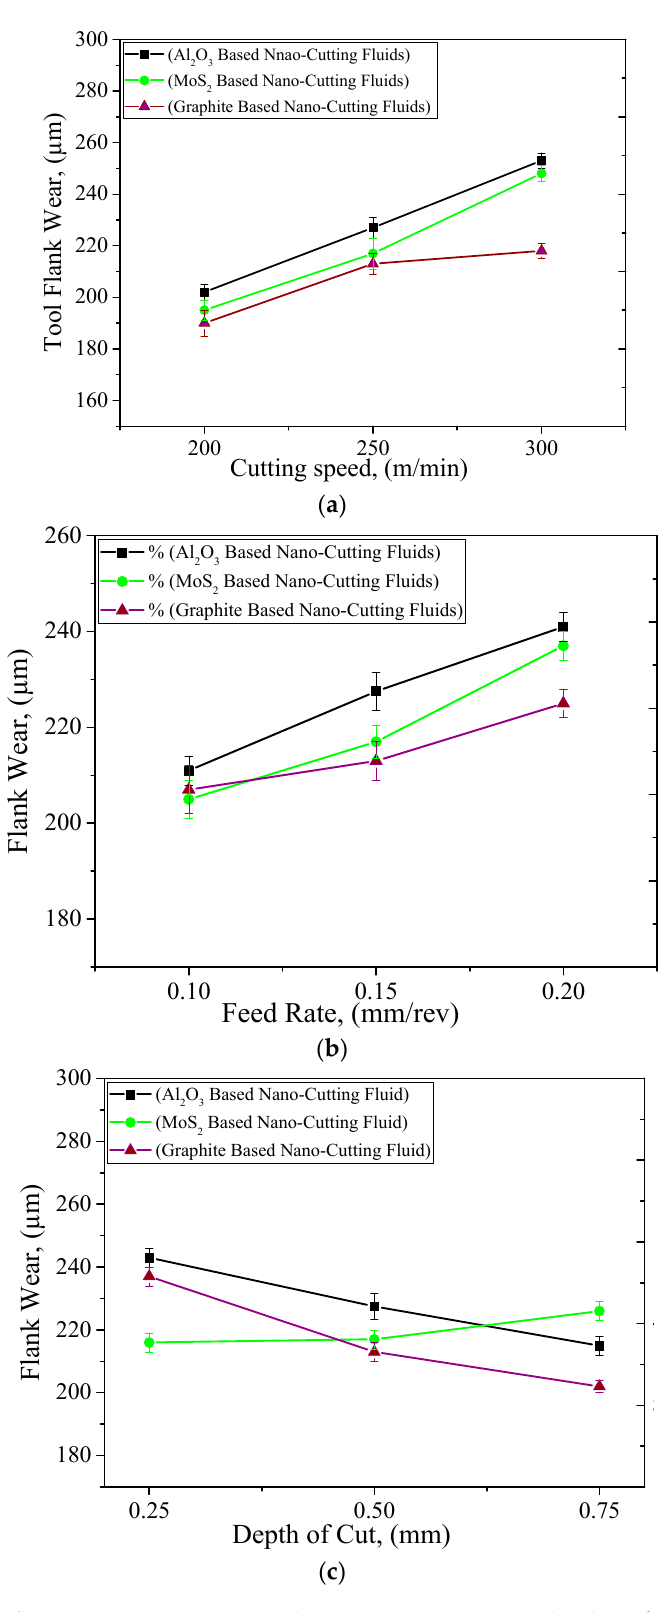
Figure 5. Effect of cutting parameters on tool wear. ( a ) Cutting Speed, where f = 0.15 mm/rev & a p = Figure 5. E ff ect of cutting parameters on tool wear. ( a ) Cutting Speed, where f = 0.15 mm / rev & a p = 0.50 mm; ( b ) Feed Rate, where Vc = 250 mm / rev and a p = 0.50 mm; ( c ) Depth of Cut, where 0.50 mm; ( b ) Feed Rate, where Vc = 250 mm/rev and a p = 0.50 mm; ( c ) Depth of Cut, where Vc = 250 Vc = 250 mm / rev and f = 0.15 mm / mm/rev and f = 0.15 mm/rev.